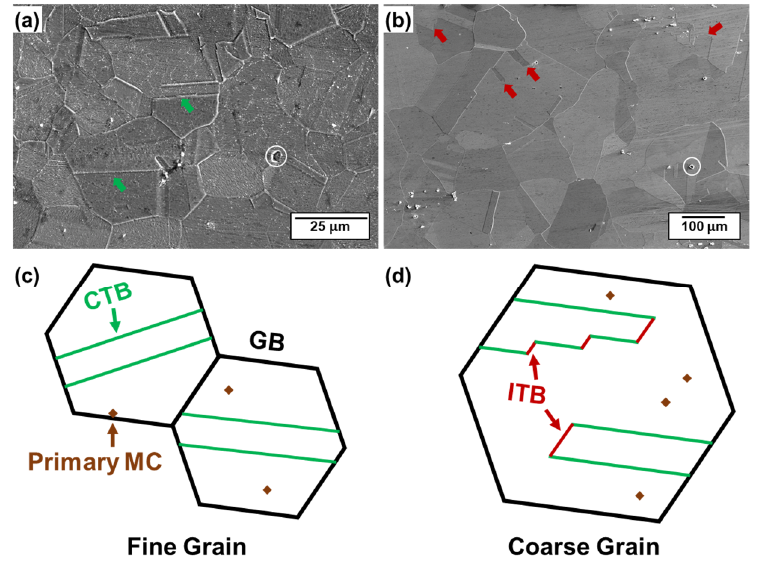
Figure 1. SEM images of ( a ) FG-S and ( b ) CG-S specimens. The green and red arrows, and white circles indicate coherent and incoherent twin boundary, and primary blocky MC carbide, respectively. Schematic images of the microstructure of ( c ) FG-S and ( d ) CG-S specimens.